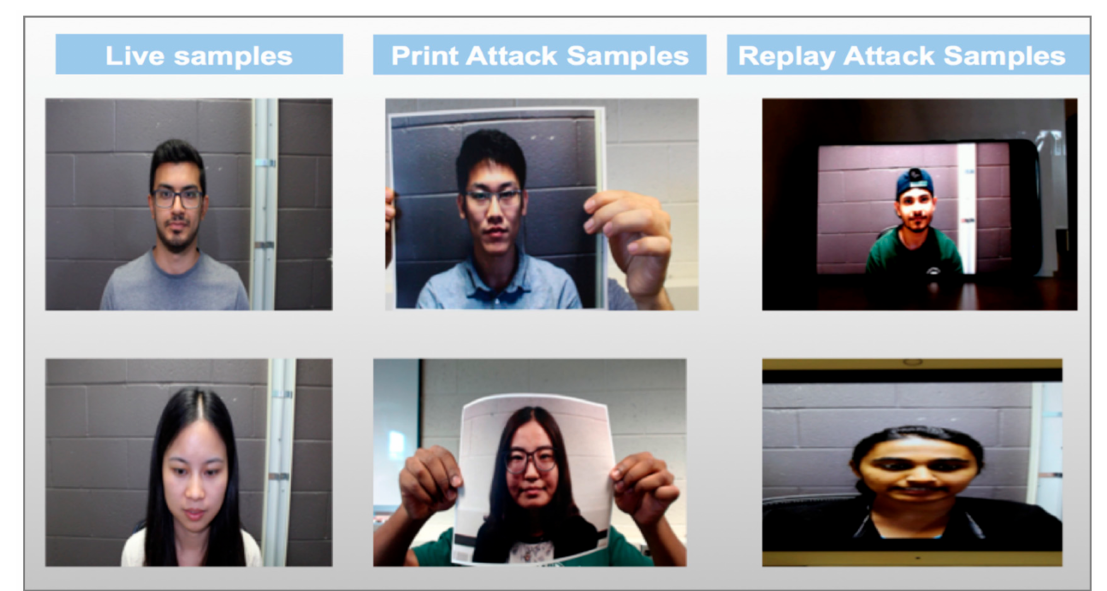
Figure 2. Samples of attacks in SiW [24].